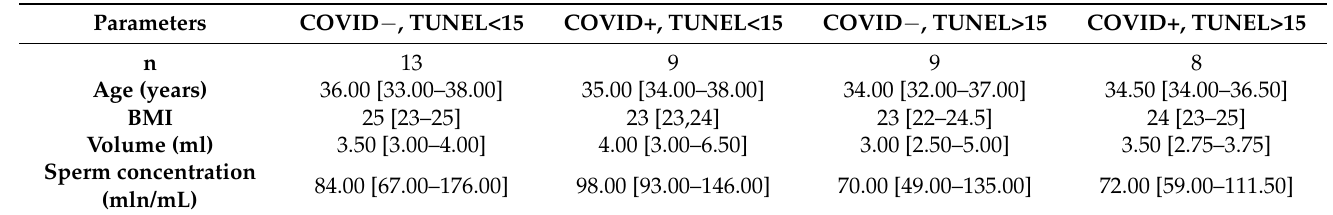
Table 3. Median and interquartile range of age, BMI and semen parameters in the groups of